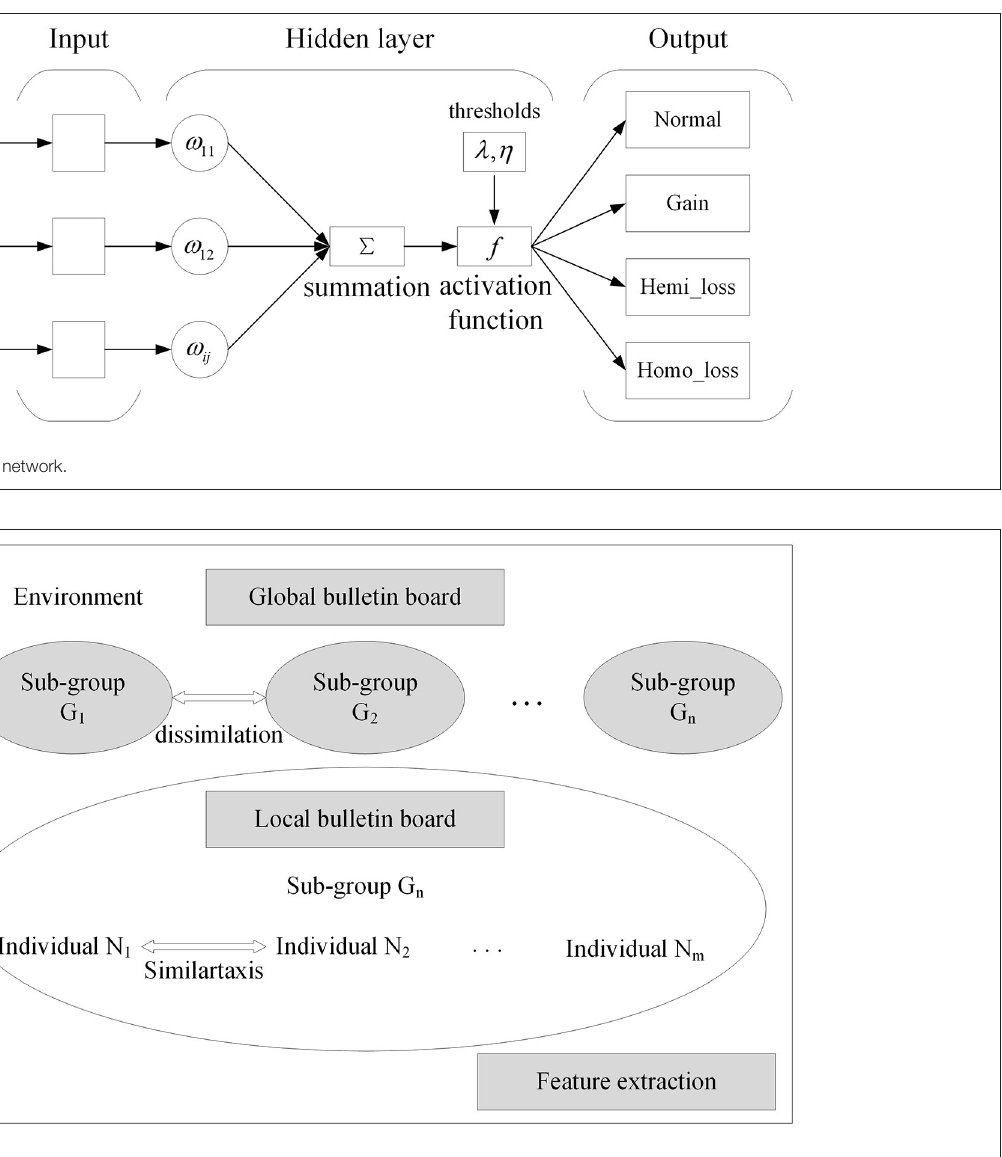
FIGURE 3 | Structure of mind evolutionary